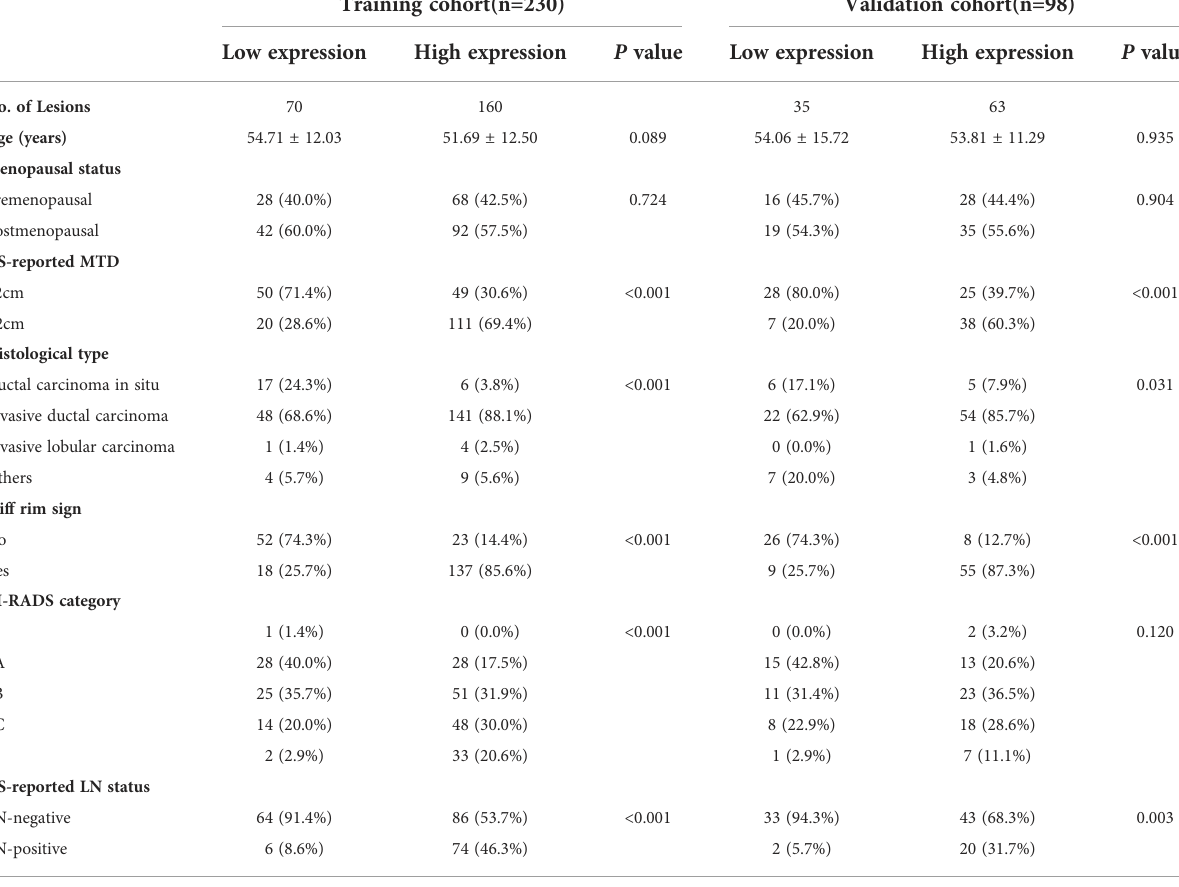
TABLE 2 Characteristics associated with Ki-67 expression status in training and validation